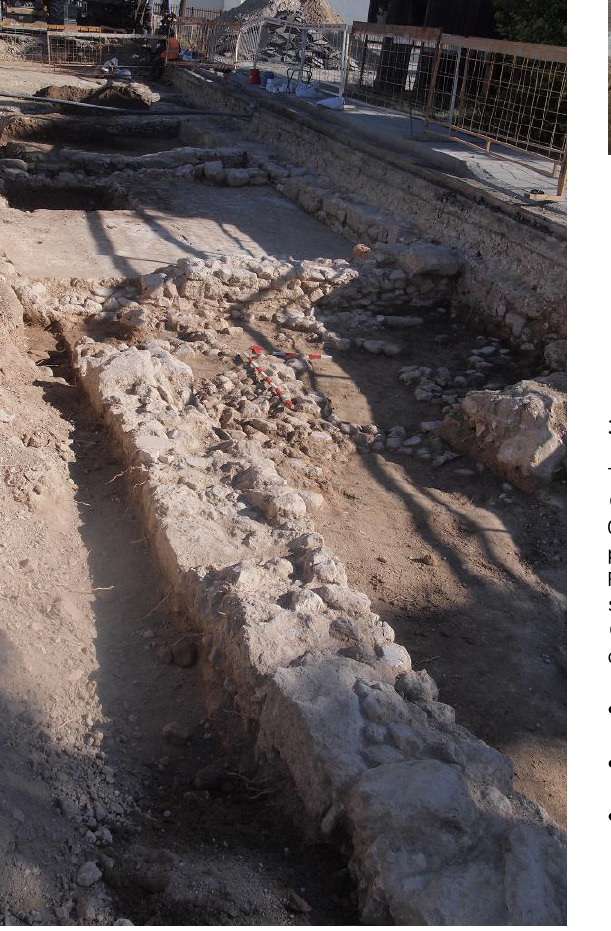
Figure 5: St. Francis Street Excavation, Larnaca, the Trench